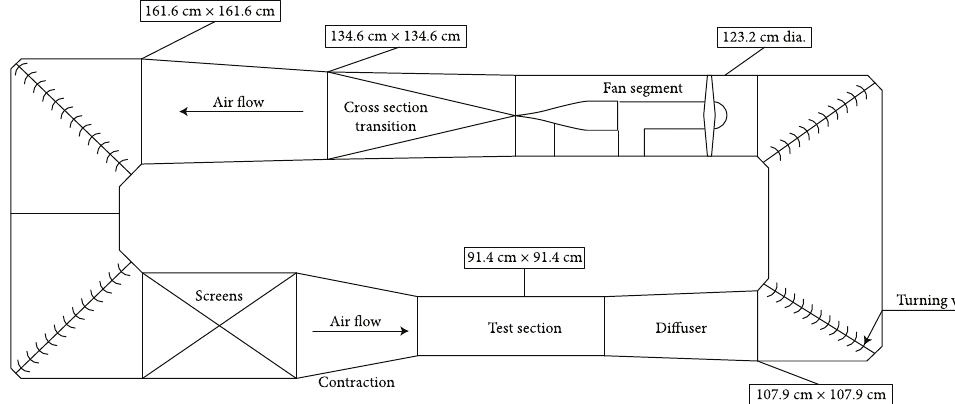
Figure 1. Ryerson University’s subsonic wind-tunnel